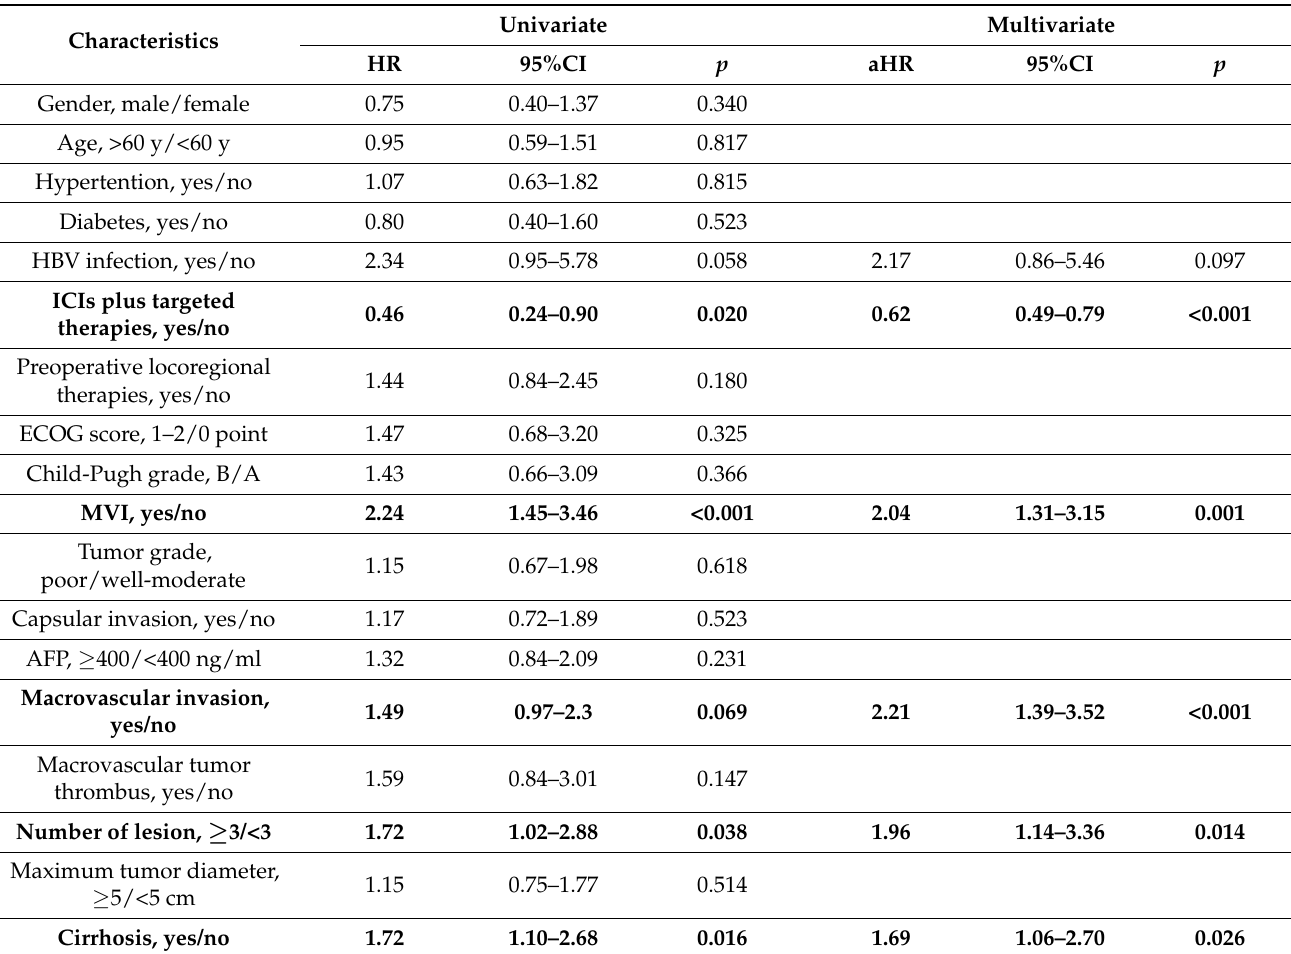
Table 3. Univariate and multivariate analyses for HCC recurrence after hepatectomy in the entire